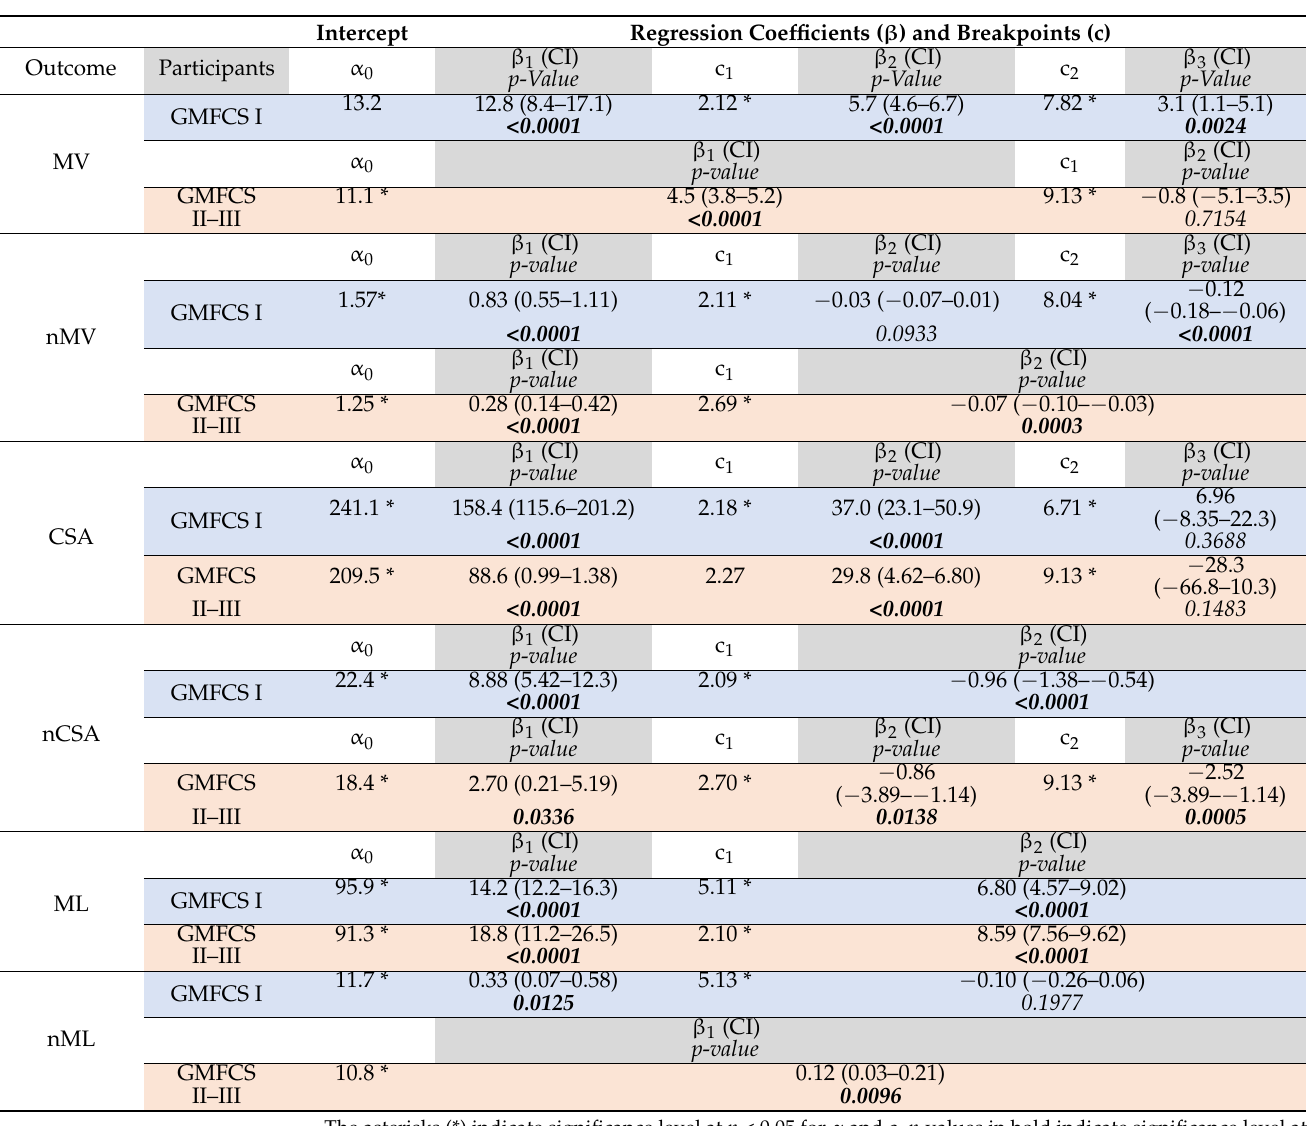
Table 2. Fixed effects of the piecewise model for muscle morphology in GMFCS subgroups (level I, n = 47; levels II–III, n =